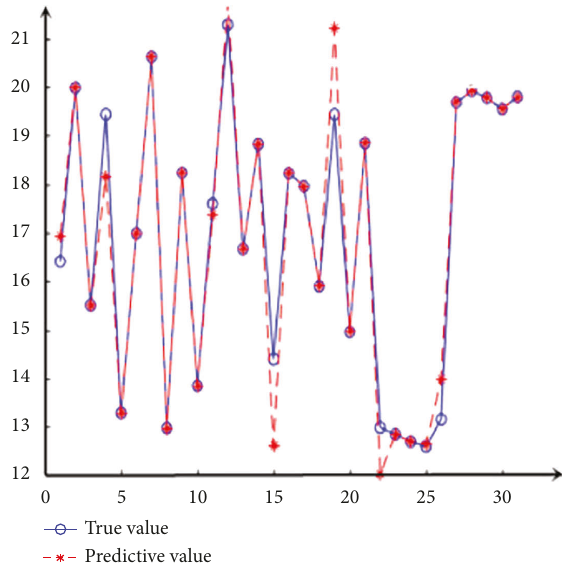
Figure 24: Optimized volume shrinkage test diagram.